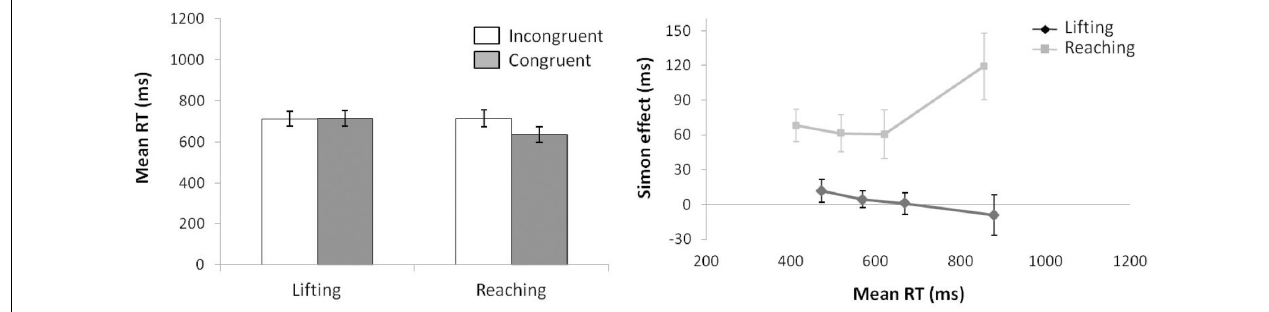
FIGURE 4 | (Left) Interactions of movement × congruence, with respect to mean reaction time. (Right) Delta-plots showing Simon effect magnitude as a function of response speed (expressed in reaction time quartiles) for lifting and reaching actions in Experiment 2. Error bars represent the standard error of the mean.